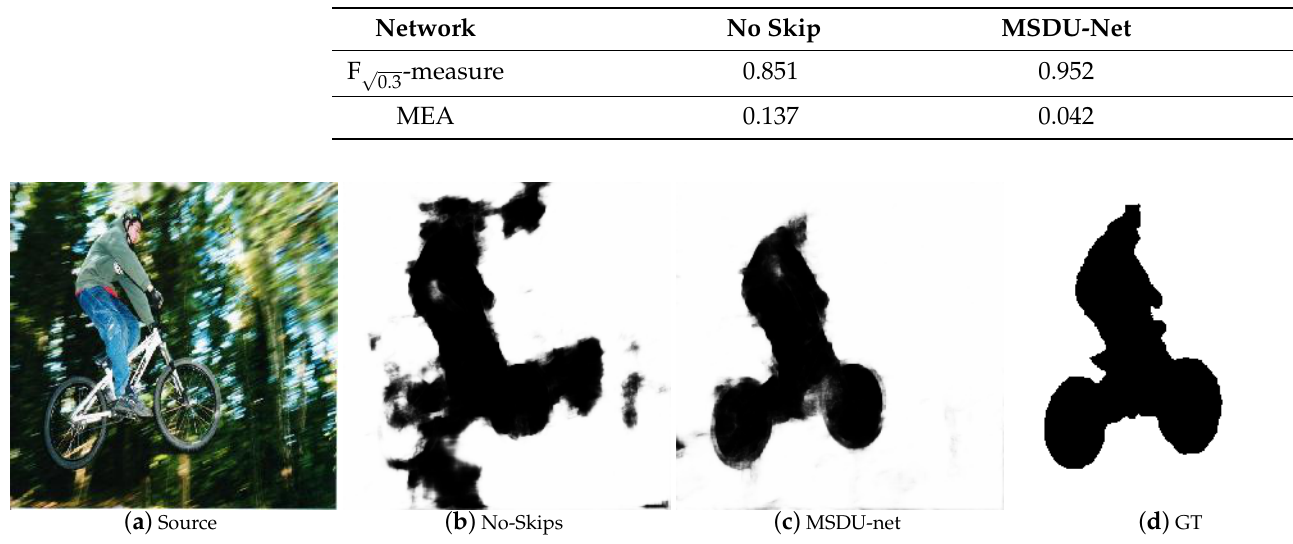
Table 2. Quantitative comparison of F √ model without skip connections.